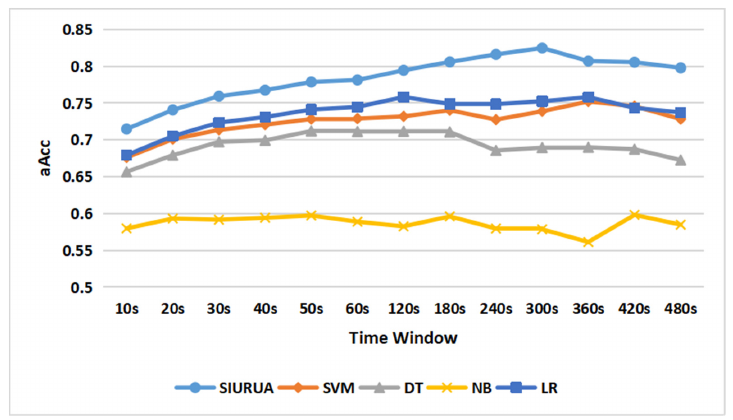
Figure 8. The accuracy of each algorithm in different value of time windows.